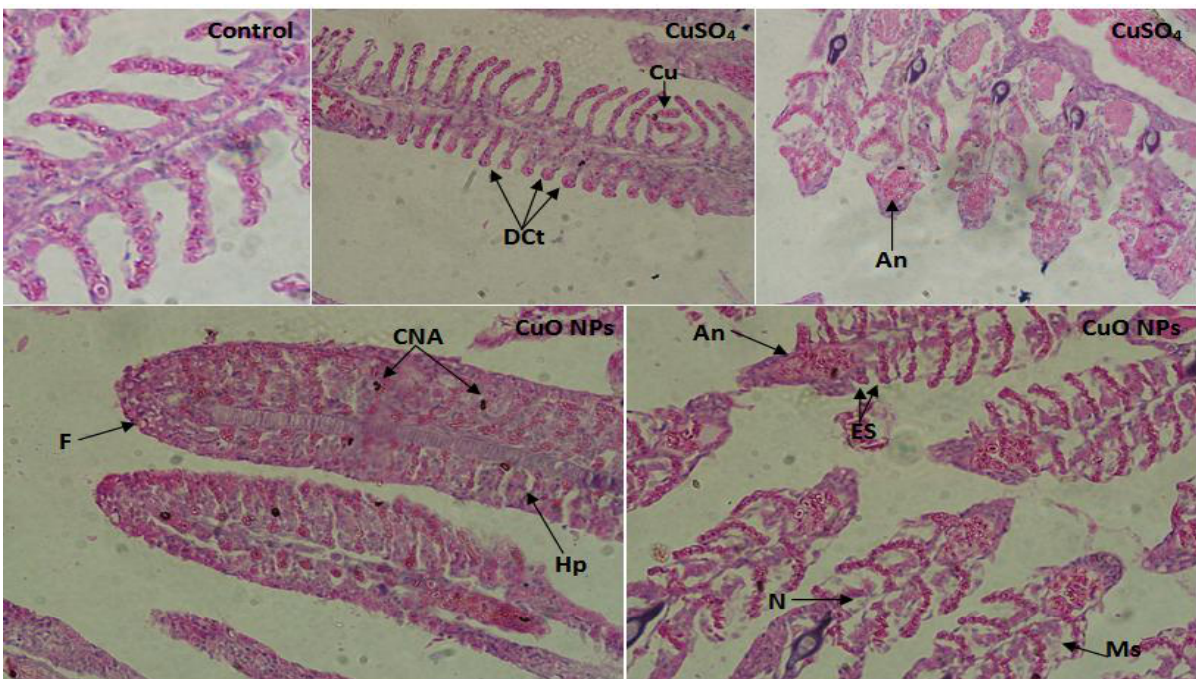
Figure 2. Histological alterations in the gills of guppy after 10 days of exposure to CuO-NPs and Cu ++ (x40) Gills of fish in the control group showed only some minor histopathological alterations, whereas treatment groups showed injuries including aneurism (An), dilated and clubbed tips (DCt), hyperplasia (Hp), epithelium shortening (ES), curvature (Cu), fusion of lamellae (F), increased mucous secretion (Ms), and necrosis (N). Table 2. Summarized histopathological effects of 20 µg/l CuO-NPs and Cu ++ on the gill of guppy Damages